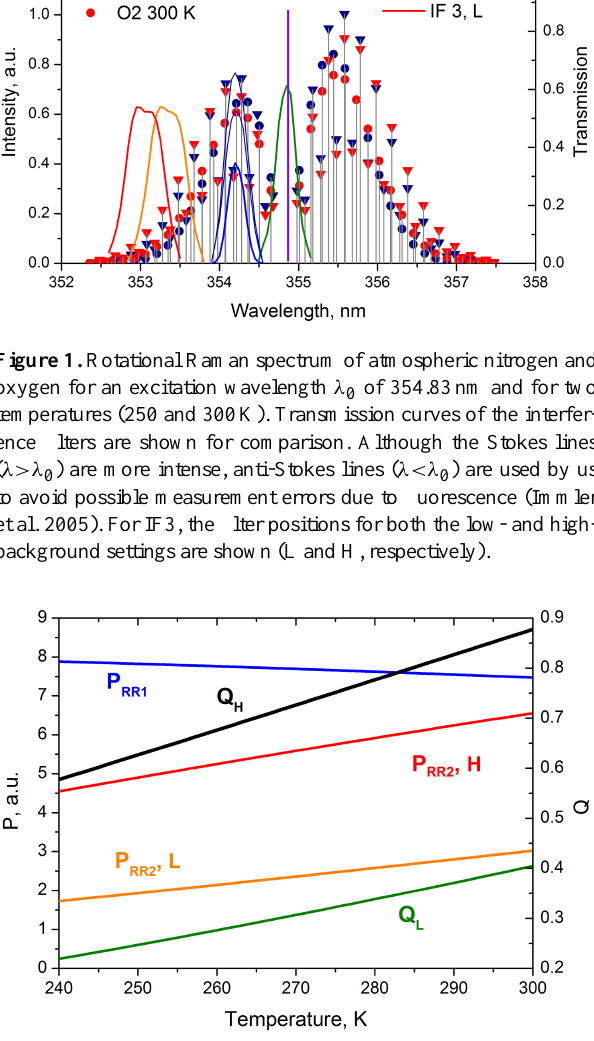
Figure 2. Simulated signal intensities for the filter configurations shown in Fig. 1: rotational Raman signal intensities for the H and L setting and corresponding ratios Q = P RR2 /P RR1